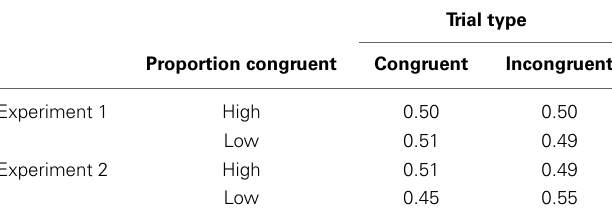
Table 2 | Participants’ mean proportion congruency estimates for Experiments 1 and